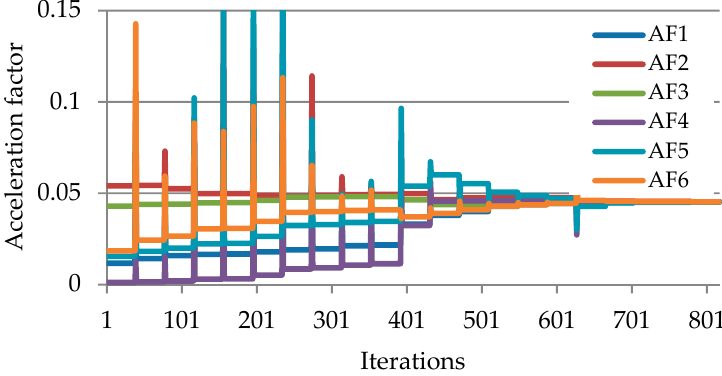
Figure 4. Acceleration factors at each optimization iterations (case 1).